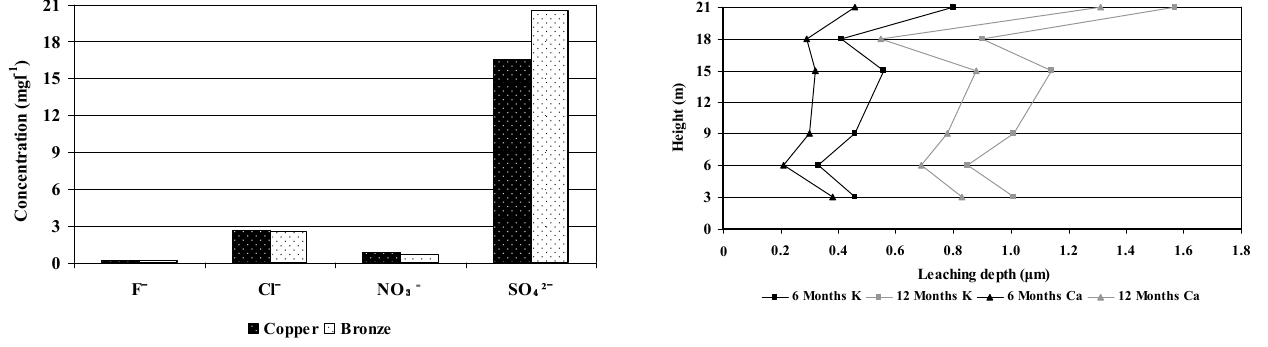
Fig. 10. Leaching depth of the specimens as a function of height.